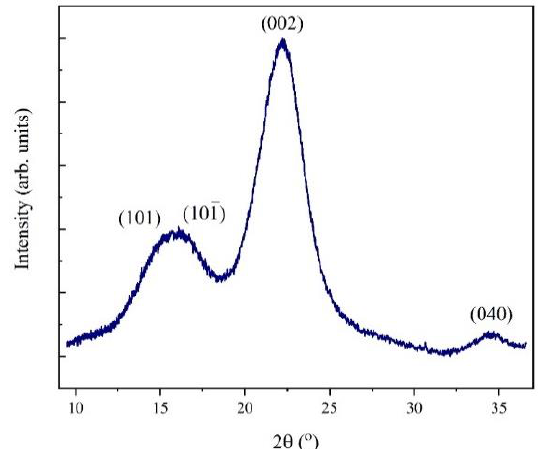
Figure 1. XRD pattern for the cellulosic material extracted from rose stems (CRS) sample, indicating the different associated crystalline planes.